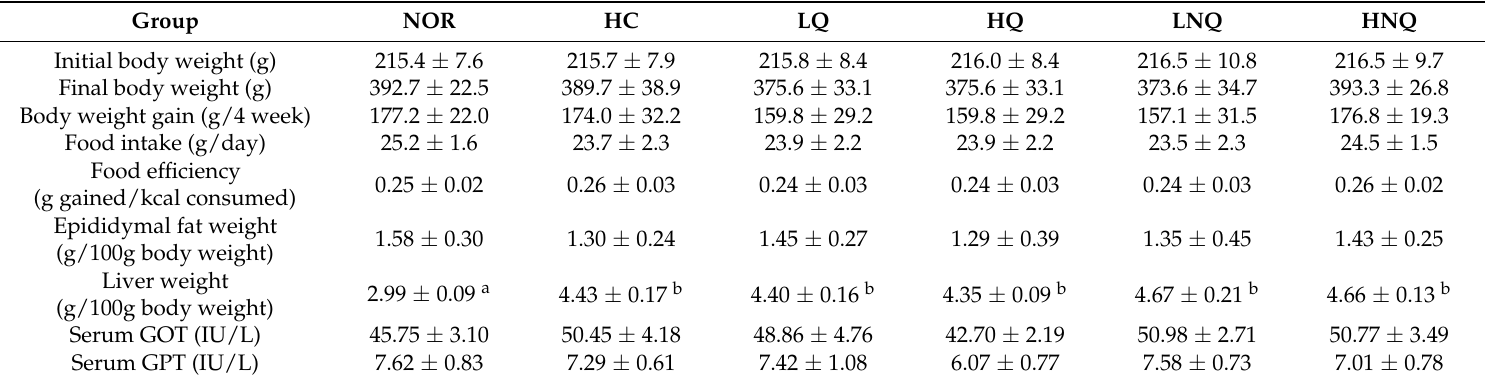
Table 2. Effects of quercetin and quercetin nanoemulsion on physiological